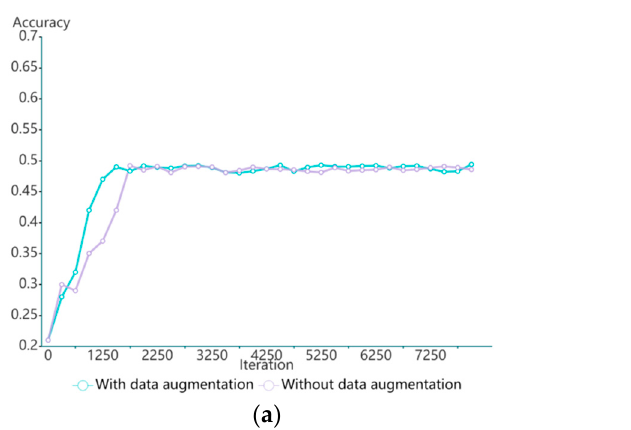
Figure 7. Classification accuracies with or without data enhancement in ( a ) the 5-way 1-shot case and ( b ) the 5-way 5-shot case.